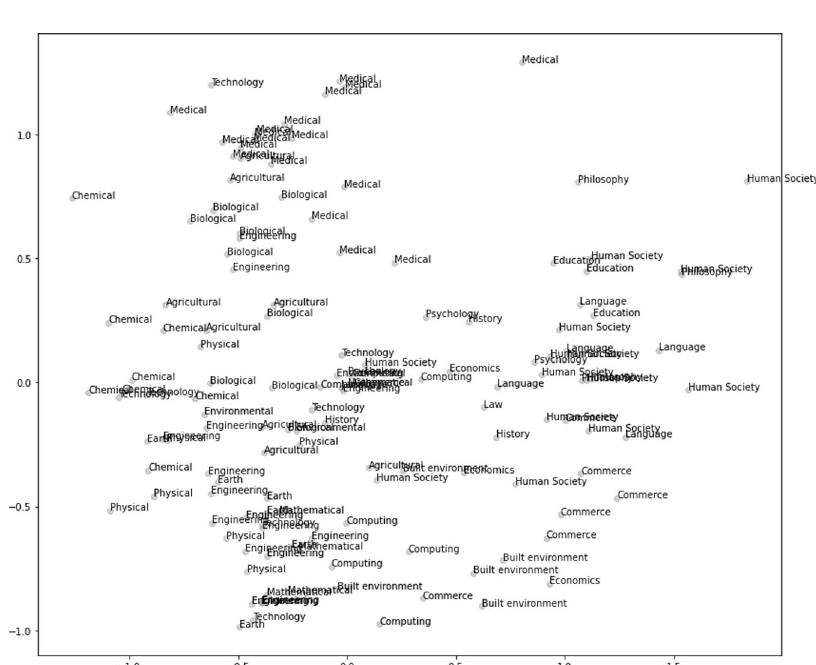
Fig. 6 Biplot of PCA-transformed embedding vectors. The arch or “ horseshoe ” shape indicates a gradient, which correlates with the natural sciences/ humanities and social sciences continuum. A vertical line across the middle of the plot would approximately correspond to the STEM/HSS distinction. The x -axis accounts for 41% of the variation in the data, while the y -axis accounts for 27%. Labels are higher-level (level-2) codes. Label codes have been shortened for